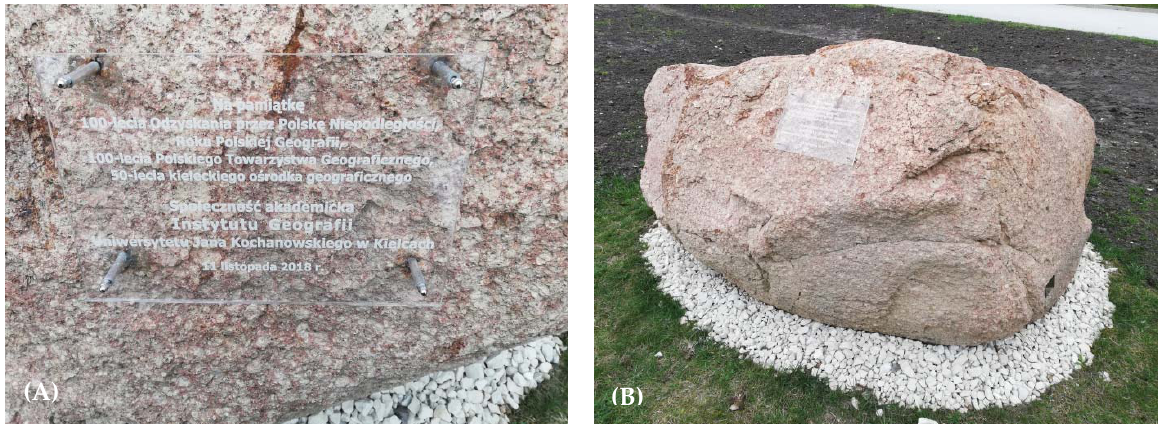
Figure 6. ( A ) A commemorative plaque unveiled on an erratic boulder. ( B ) for the 100th anniversary of Poland regaining independence; rapakivi granite from the Åland Islands (boulder No. 17 in the leaflet [141]).